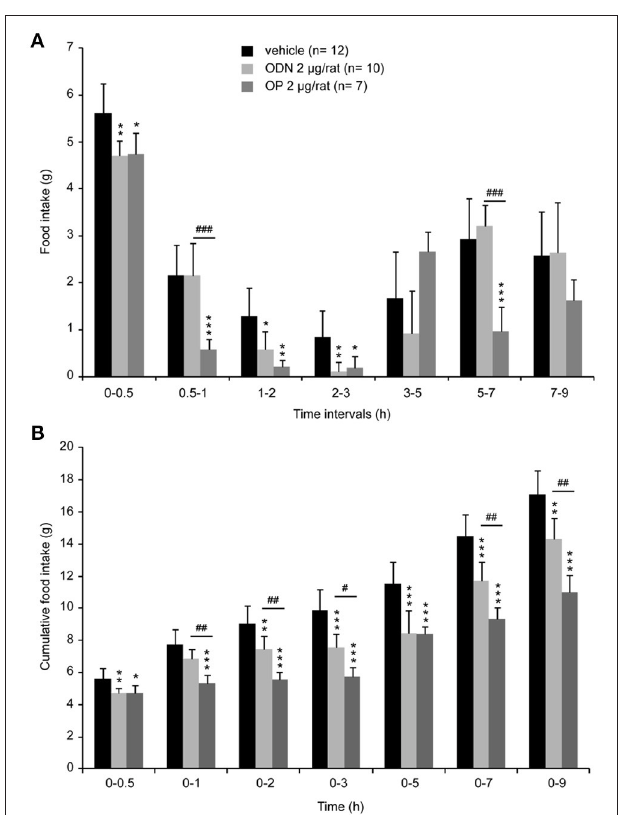
FIGURE 5 | Continued fibrous glial process positive for ODN (arrowheads). (D) RT-PCR of DBI mRNA from hypothalamus (Hpt) and dorsal vagal complex (DVC) extracts. Scale bars: 500 nm in A; 1 µ m in B and C. Ast, astrocytes; d, dendritic profiles; Ax, axon terminals; G, glial process.